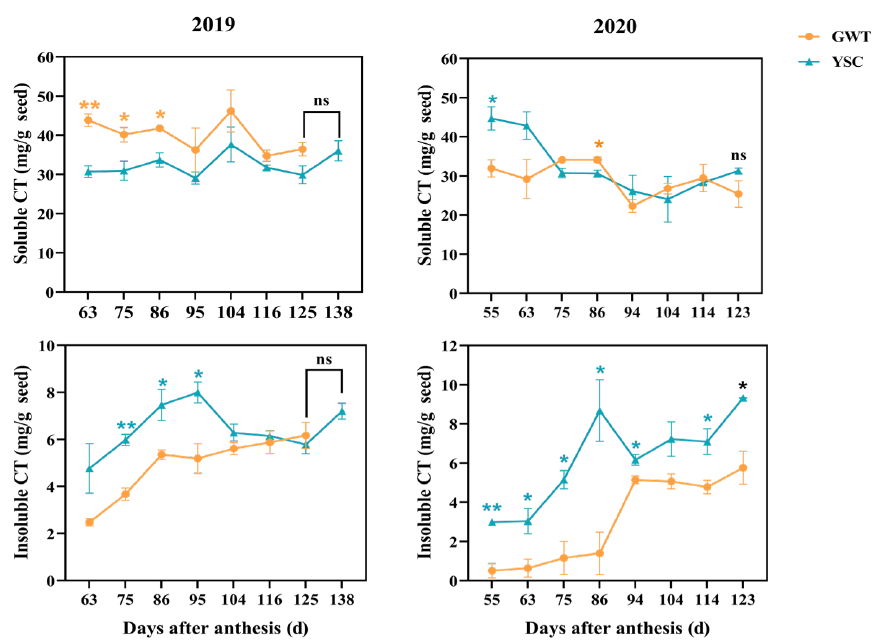
Figure 3. Variation of soluble and insoluble CT content in GWT and YSC seeds in 2019 and 2020. The asterisk indicates that there is a statistical difference between the 2 vineyards in the same period at the 0.05 level:*, p < 0.05; **, p < 0.01; ns, not significant. Table 1. Two-way ANOVA for effects of year and plot on soluble and insoluble CT content in seeds. CT Type Year Plot Year × Plot Soluble CT *** ns Insoluble CT *